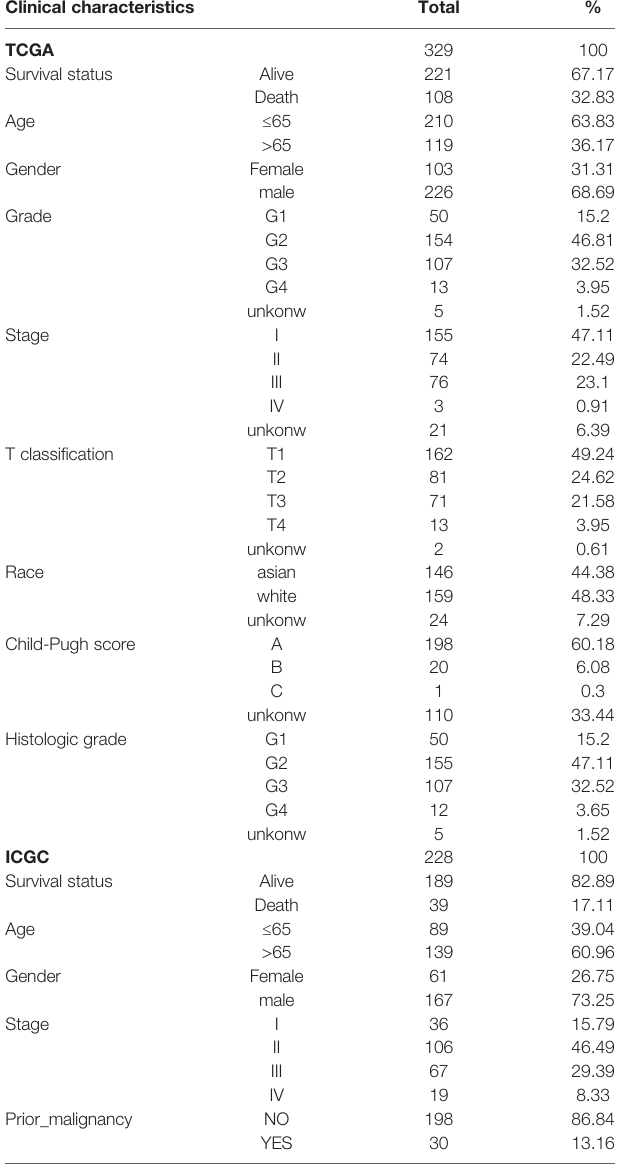
TABLE 1 | The clinical characteristics of liver cancer patients in the TCGA and ICGC cohorts. Clinical